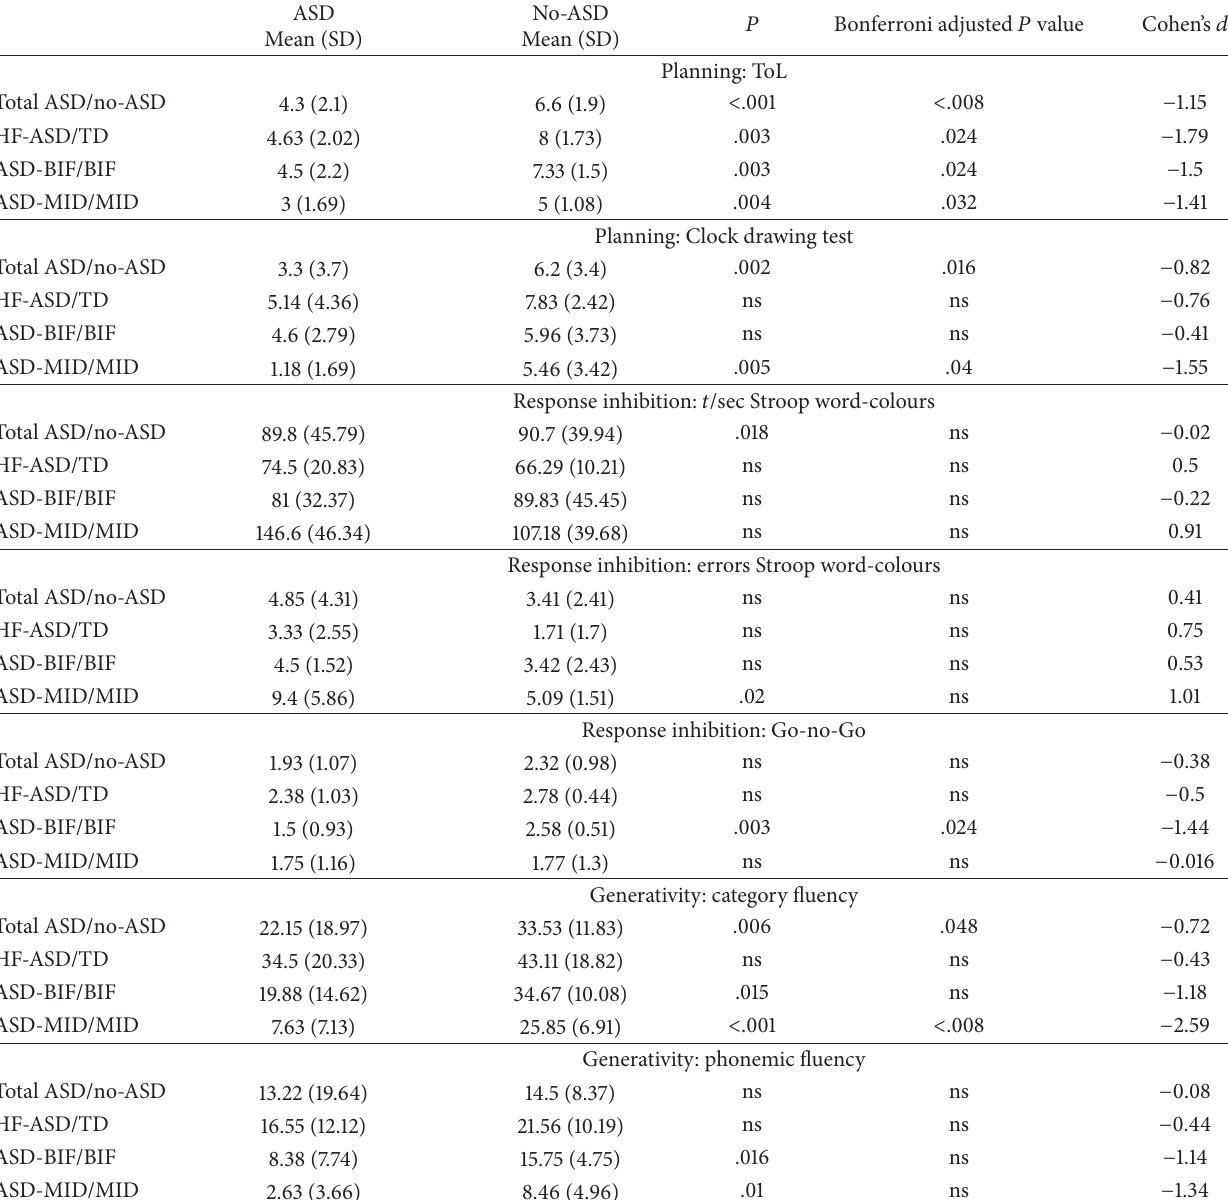
Table 2: Means, SD, and statistically significant differences ( 𝑡 test; Bonferroni correction: 𝑃 ≤ .00625 ; Cohen’s test) obtained from ASD and no-ASD groups in planning, response inhibition, and